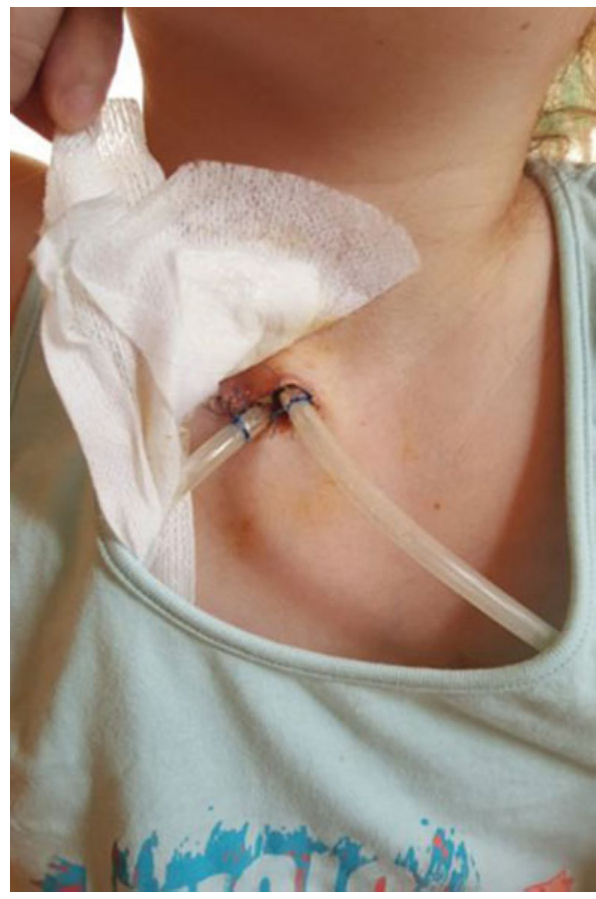
Fig. 3 The drains leading to the mediastinum via the jugular